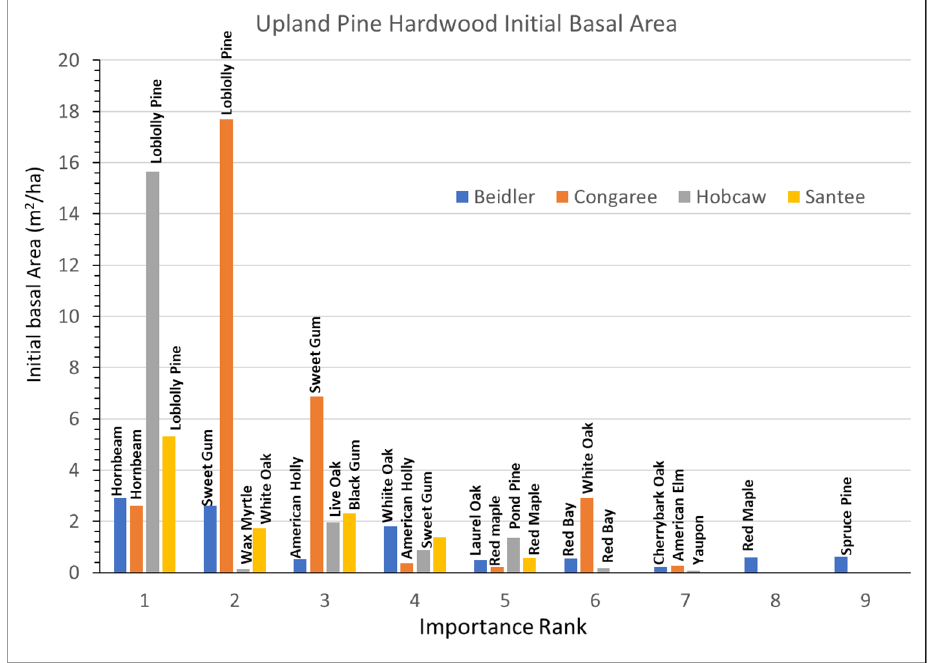
Figure 9. Distribution of initial basal area of species, by importance factor (1 means the most important, while 9 means the least important), for each study site of the upland pine-hardwood vegetation type.